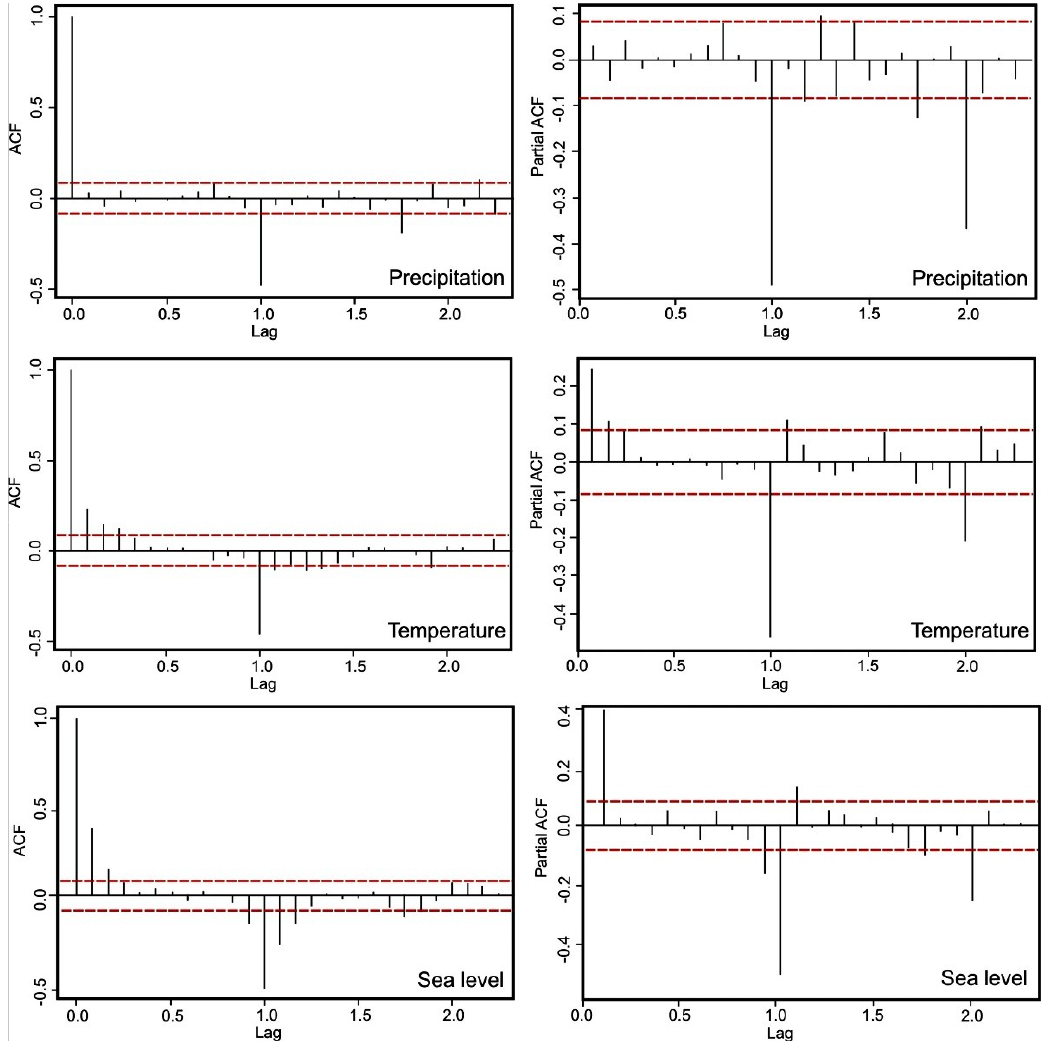
Figure 4. The course of the autocorrelation (ACF) and partial autocorrelation (PACF) functions for hydrometeorological conditions in Ustka (monthly intervals from 1966–2015).